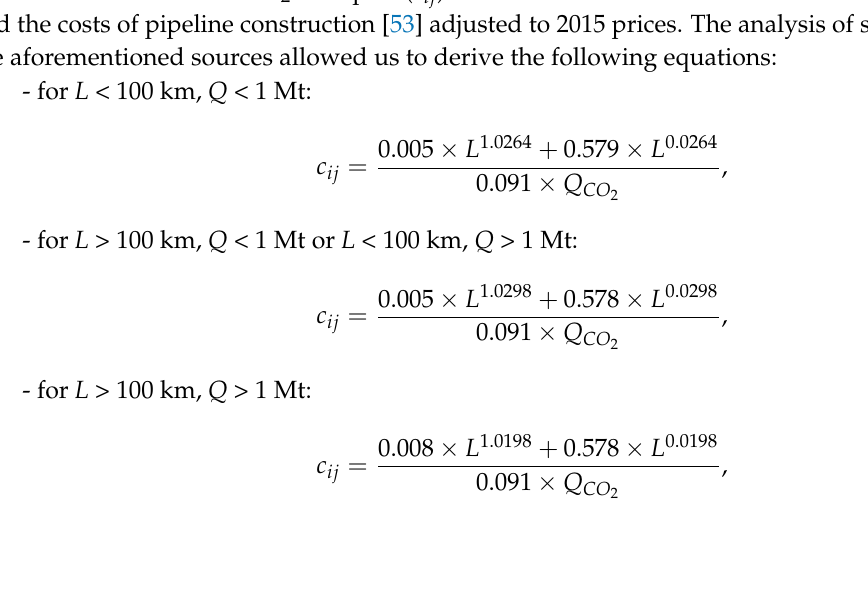
2 flow, and pipeline